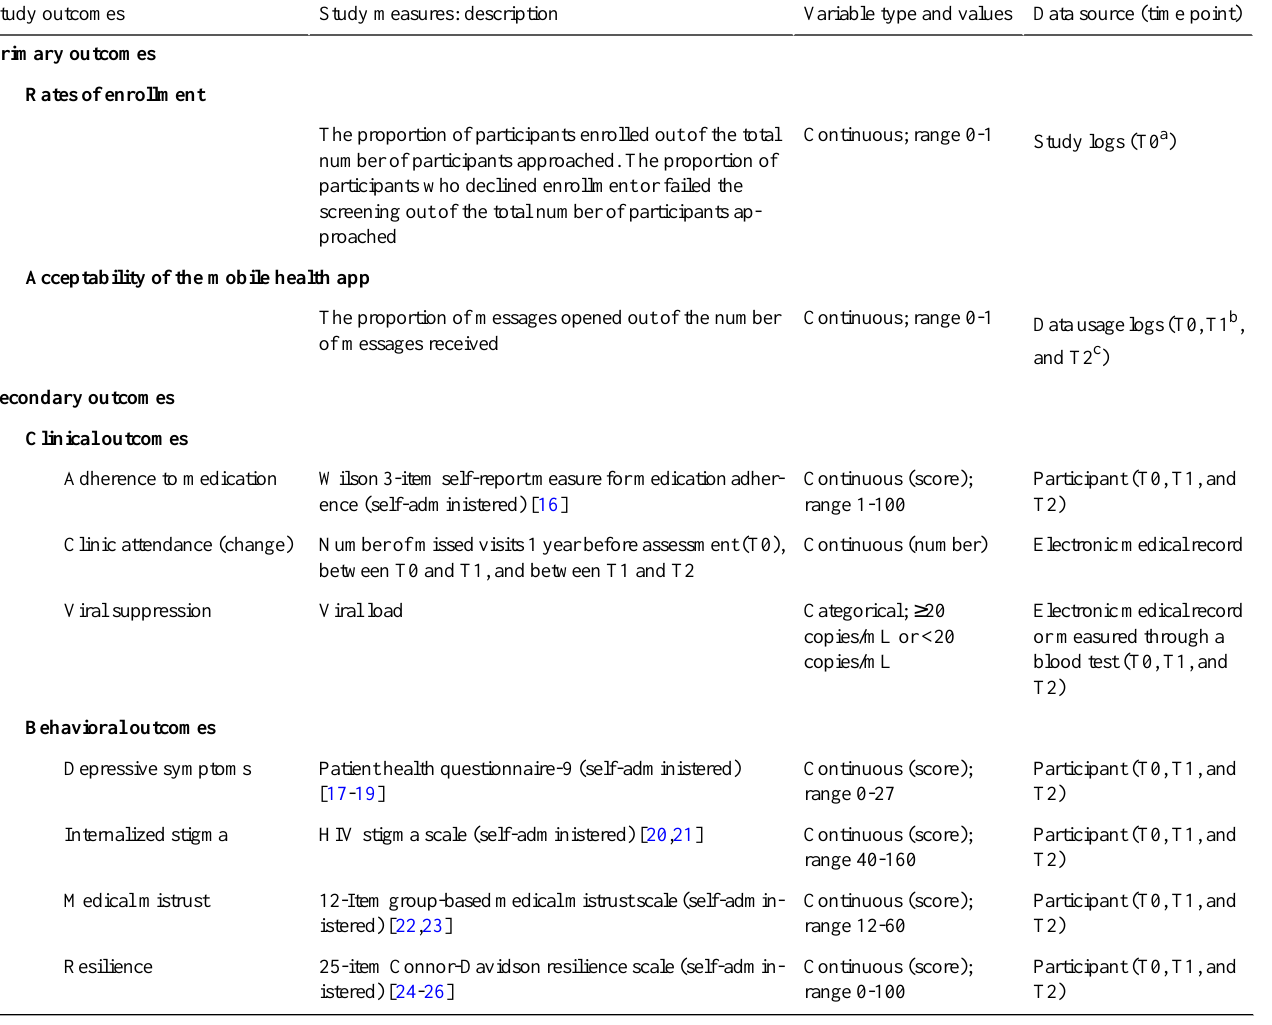
Table 1. Summary of assessments and data collected for primary and secondary study